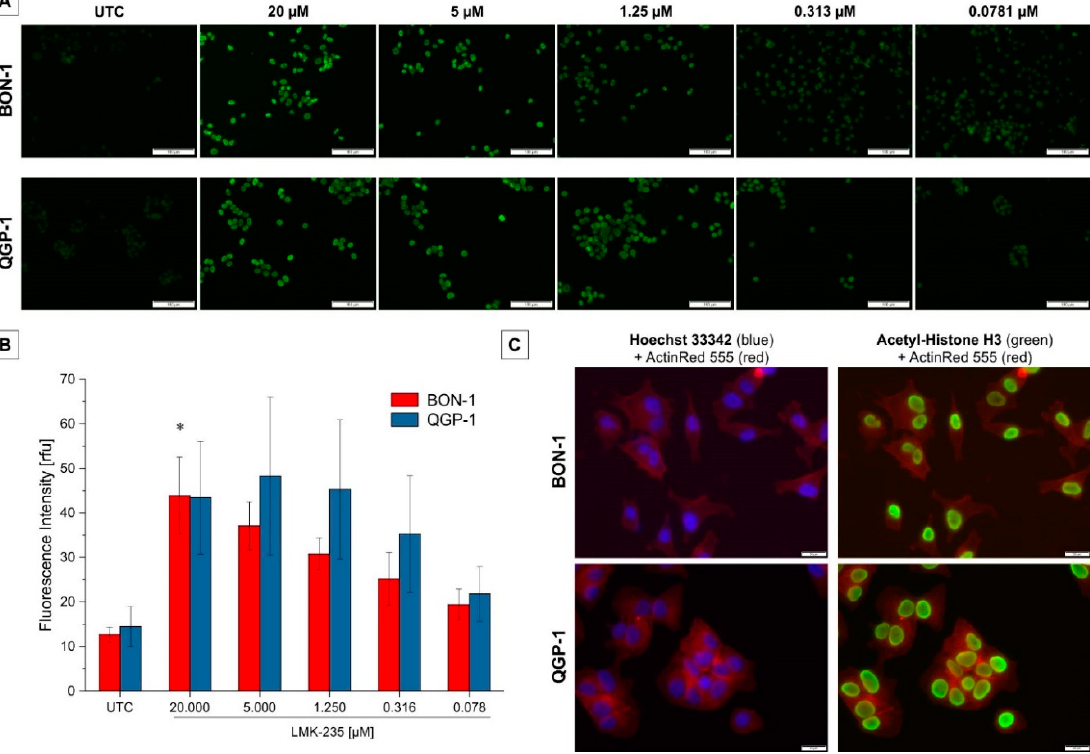
Figure 3. Acetyl-H3 immunofluorescence following LMK-235 treatment. ( A ) Results of one representative acetylated H3 immunofluorescence staining is shown for a LMK-235 dilution series for both cell lines. All samples were visualized using the same exposure time. Acetylated histone H3 is stained in green and the scale bar indicates 100 µm. Magnification 100×. ( B ) Quantitative immunofluorescence intensities are represented as bars for mean ± SEM. * indicate p < 0.05. ( C ) Overlay of ActinRed (red, cytoskeleton) with Hoechst 33342 (blue, nuclei) or acetyl-H3 (green) staining demonstrating the localization of acetyl-H3 staining exclusively in the cells’ nuclei. Magnification 200 × . Abbreviations: UTC = untreated control.